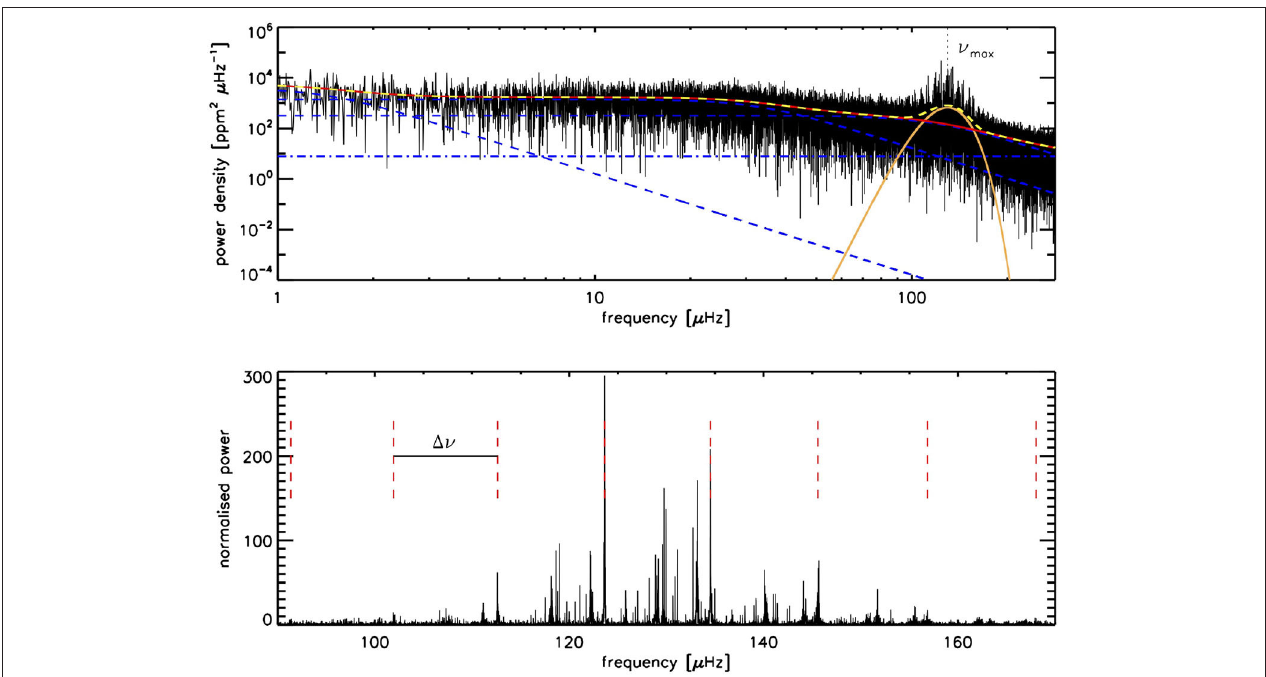
FIGURE 2 | Top : Power density spectrum of KIC 6144777 with the data shown in black. The granulation components are indicated with blue dashed lines and the white noise with the blue dashed-dotted line. The sum of the granulation components and noise comprise the background fit, which is shown with the red solid line. The Gaussian fit to the power excess is shown in orange with the frequency of maximum oscillation power ( ν max ) indicated by the vertical dotted line. The complete fit (background + oscillation power excess) is shown with the yellow dashed line. Bottom: The power spectrum after the background correction. The regular pattern of radial modes is indicated with the vertical red dashed lines. The distance in frequency between these lines is the large frequency separation 1ν